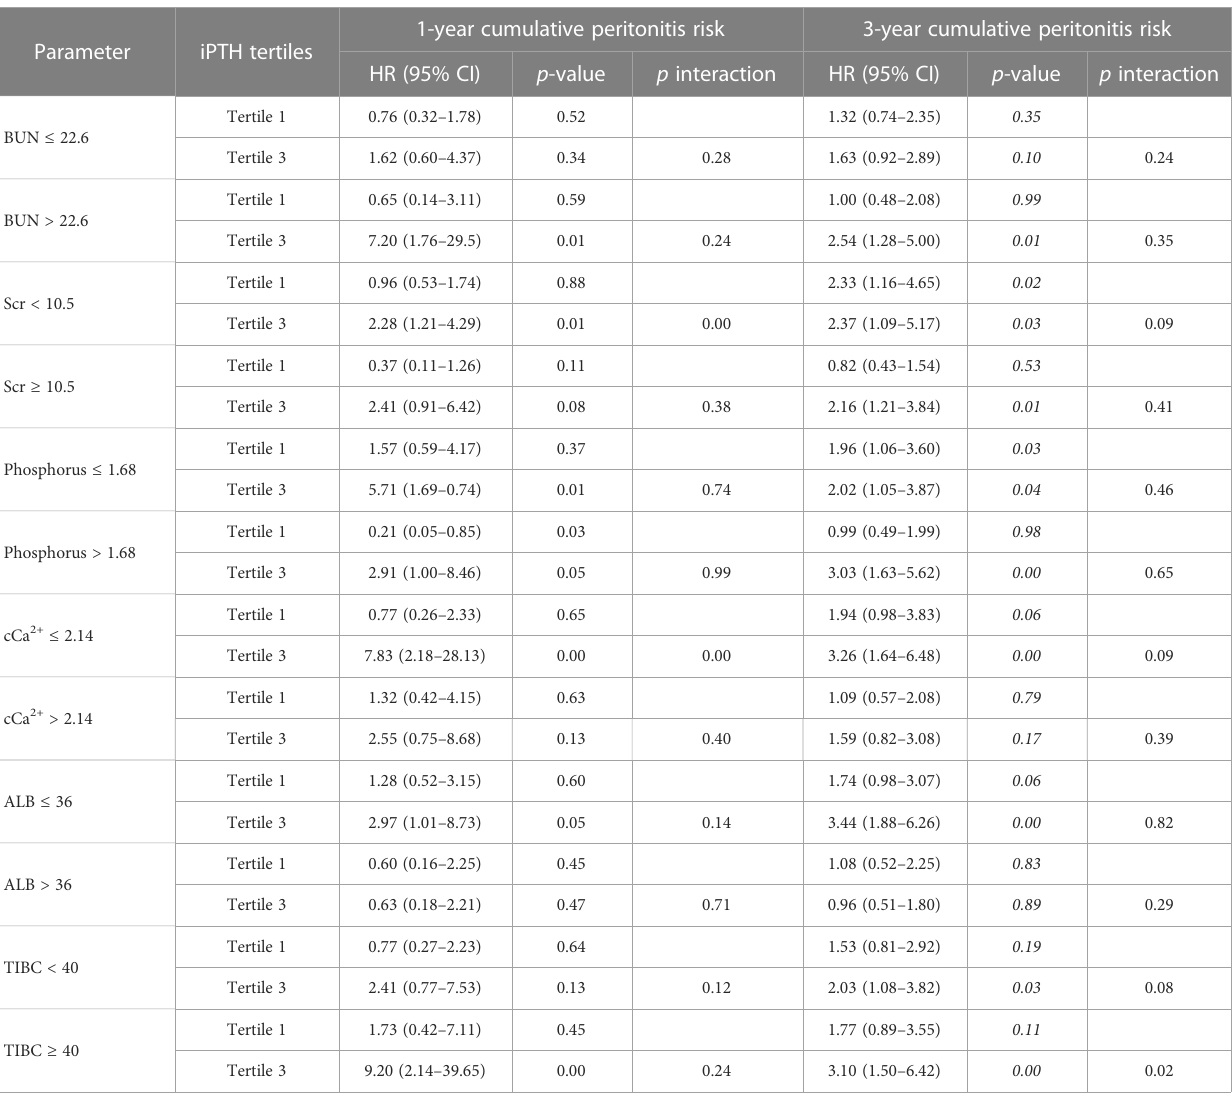
TABLE 6 Strati fi ed analyses based on various clinical markers.